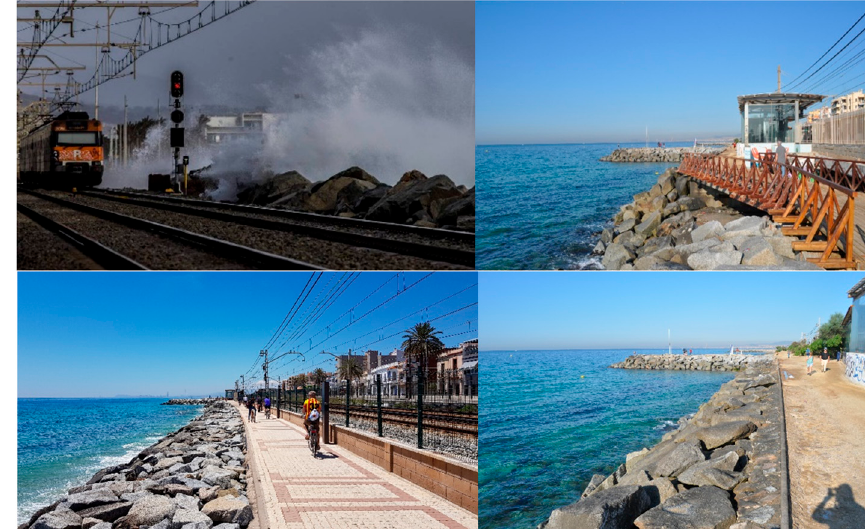
Figure 3. Photographs representing the current state of the study area.